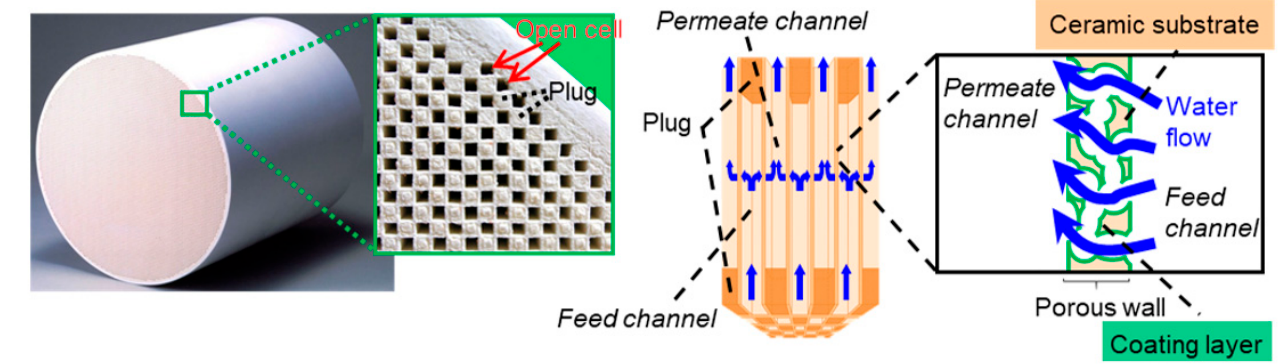
Figure 1. Photography of the CAF structure and diagram of the water flow path in CAF. Adapted from [23].